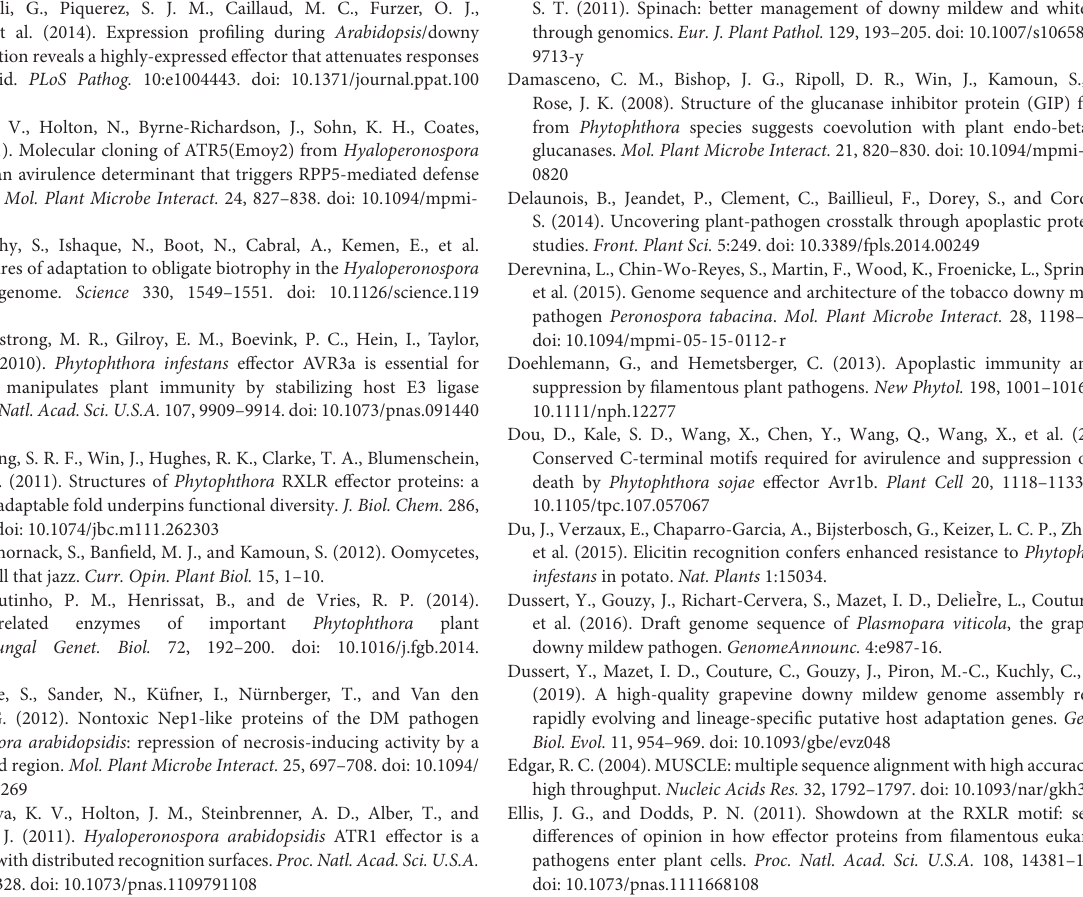
TABLE S5 | Secretome annotations and amino acid sequences Pseudoperonospora cubensis. TABLE S6 | Predicted apoplastic effectors in Pseudoperonospora cubensis , their annotation, SignalP HMM score, signal peptide position, and amino acid sequences. The different classes are separated in different sheets.